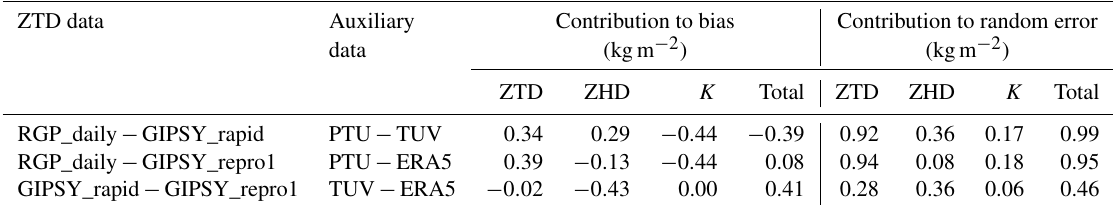
Table 4. Separation of bias (mean) and random errors (1 standard deviation) of IWV differences into contributions from ZTD differences, ZHD differences, and K differences, for two operational data streams (RGP daily and GIPSY rapid) and the reprocessed stream (GIPSY repro1). The three streams involve different auxiliary data for the ZTD-to-IWV conversion from PTU, TUV, and ERA5. See text for more